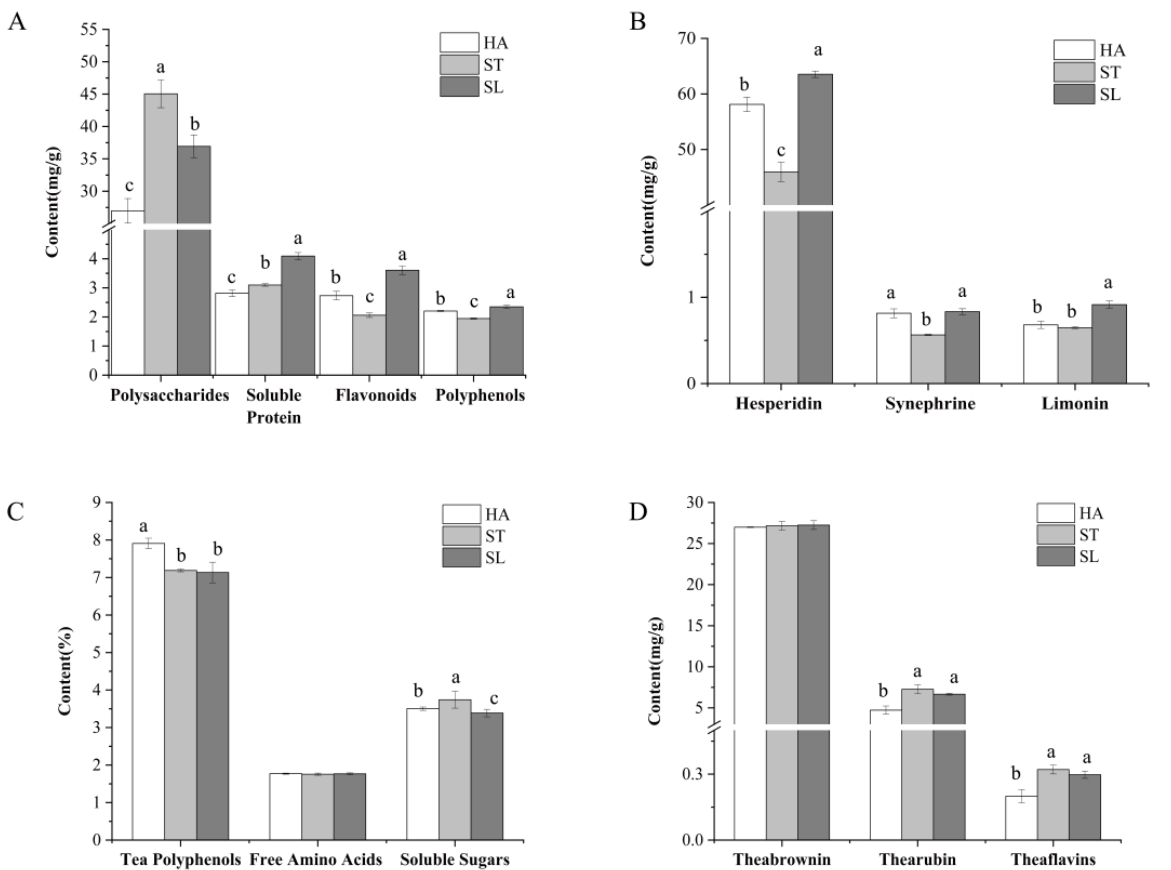
Figure 2. Effects of different fixing methods on main biochemical compositions of orange dark tea. ( A , B ) Effects of different fixing methods on the main chemical components in the peel. ( C , D ) Effects of different fixing methods on the main chemical components in the tea. HA, hot air fixing; ST, steam fixing; SL, sunlight fixing. Different small letters indicate significant difference at p < 0.05.